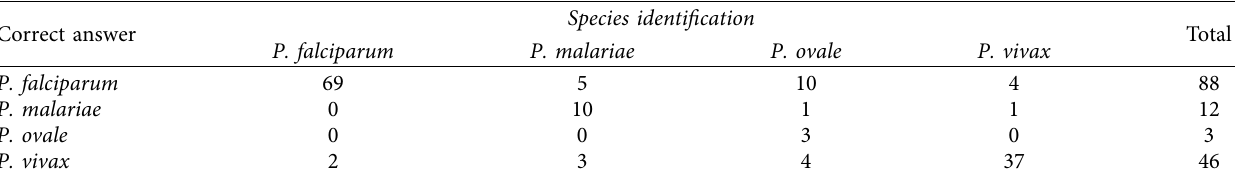
Table 4: Species identification of the Plasmodium -positive slides correctly in the qualitative microscopy by provincial-level representatives from medical institutes.